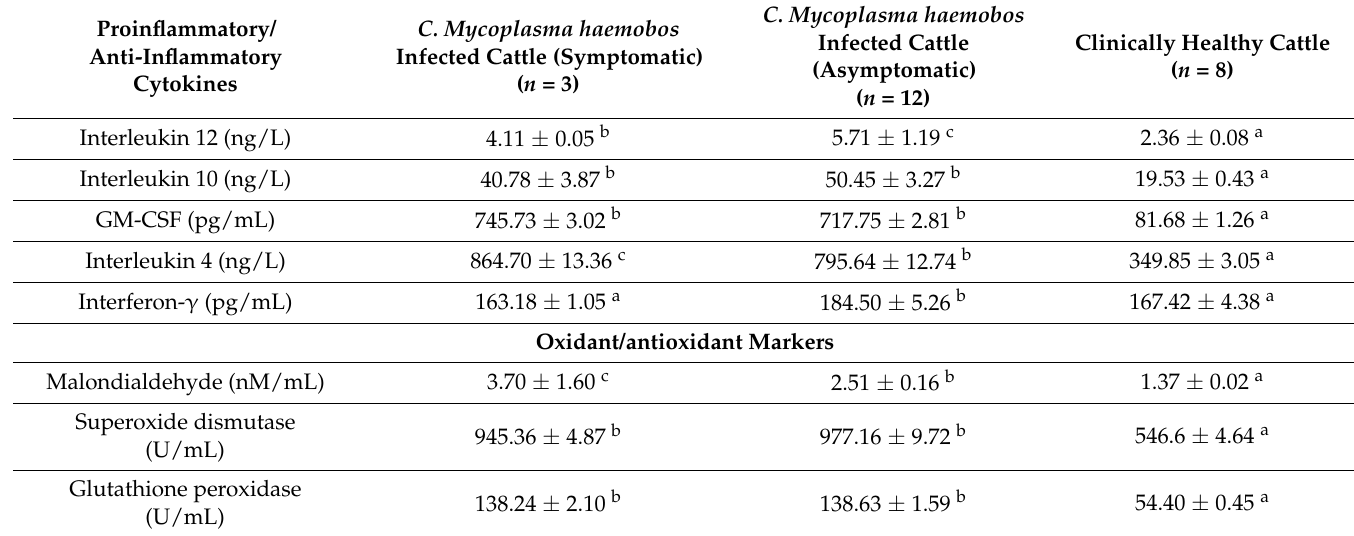
Table 3. The serum inflammatory cytokine and oxidant/antioxidant levels in symptomatic and asymptomatic cattle naturally infected with Candidatus Mycoplasma haemobos